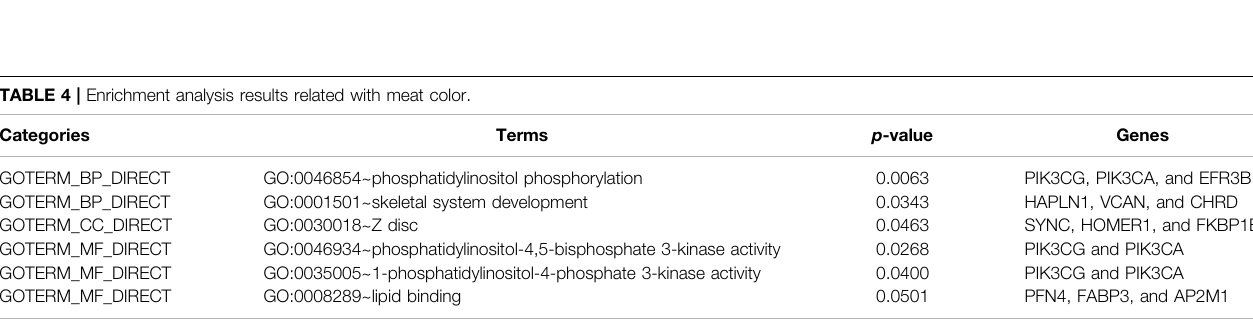
TABLE 4 | Enrichment analysis results related with meat